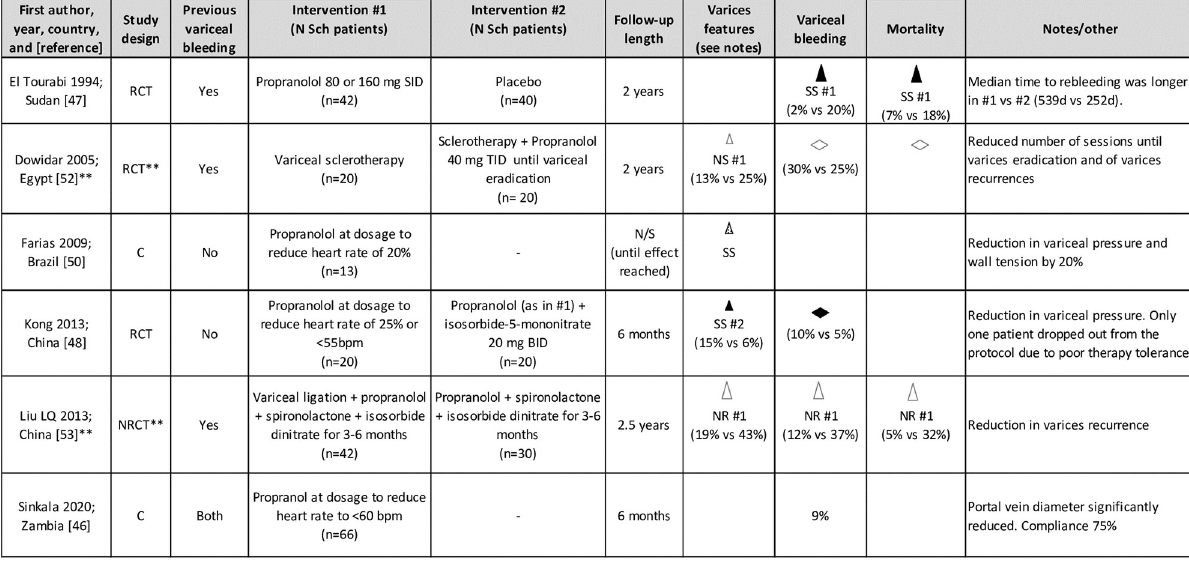
Fig 3. Direction effect chart summary of the included studies investigating the use of beta-blockers for the clinical management of hepatosplenic schistosomiasis. Evaluation of all outcomes refers to the end of follow-up. �� Data extracted from abstract. Sch, schistosomiasis. C, Cohort study. C–C, Case–Control study. RCT, Randomized Clinical Trial. NRCT, Non-Randomized Clinical Trial. N/S, not specified. Triangle orientation indicates direction of outcome: upward = amelioration in respect to other intervention or baseline, horizontal = no difference between interventions or from baseline. Triangle size indicates sample size per (smallest) group: small � 20 pts, medium 21–49 pts, large � 50 pts. Triangle color indicates quality of result based on study design and source: black = RCT, light gray = C–C, dotted = C, white = data from abstract. SS, statistically significant, NS, not statistically significant, NR, statistical analysis not reported. #n = intervention indicated in the corresponding “Intervention #n” column of the table to which the outcome direction refers [46–48,50,52,53].